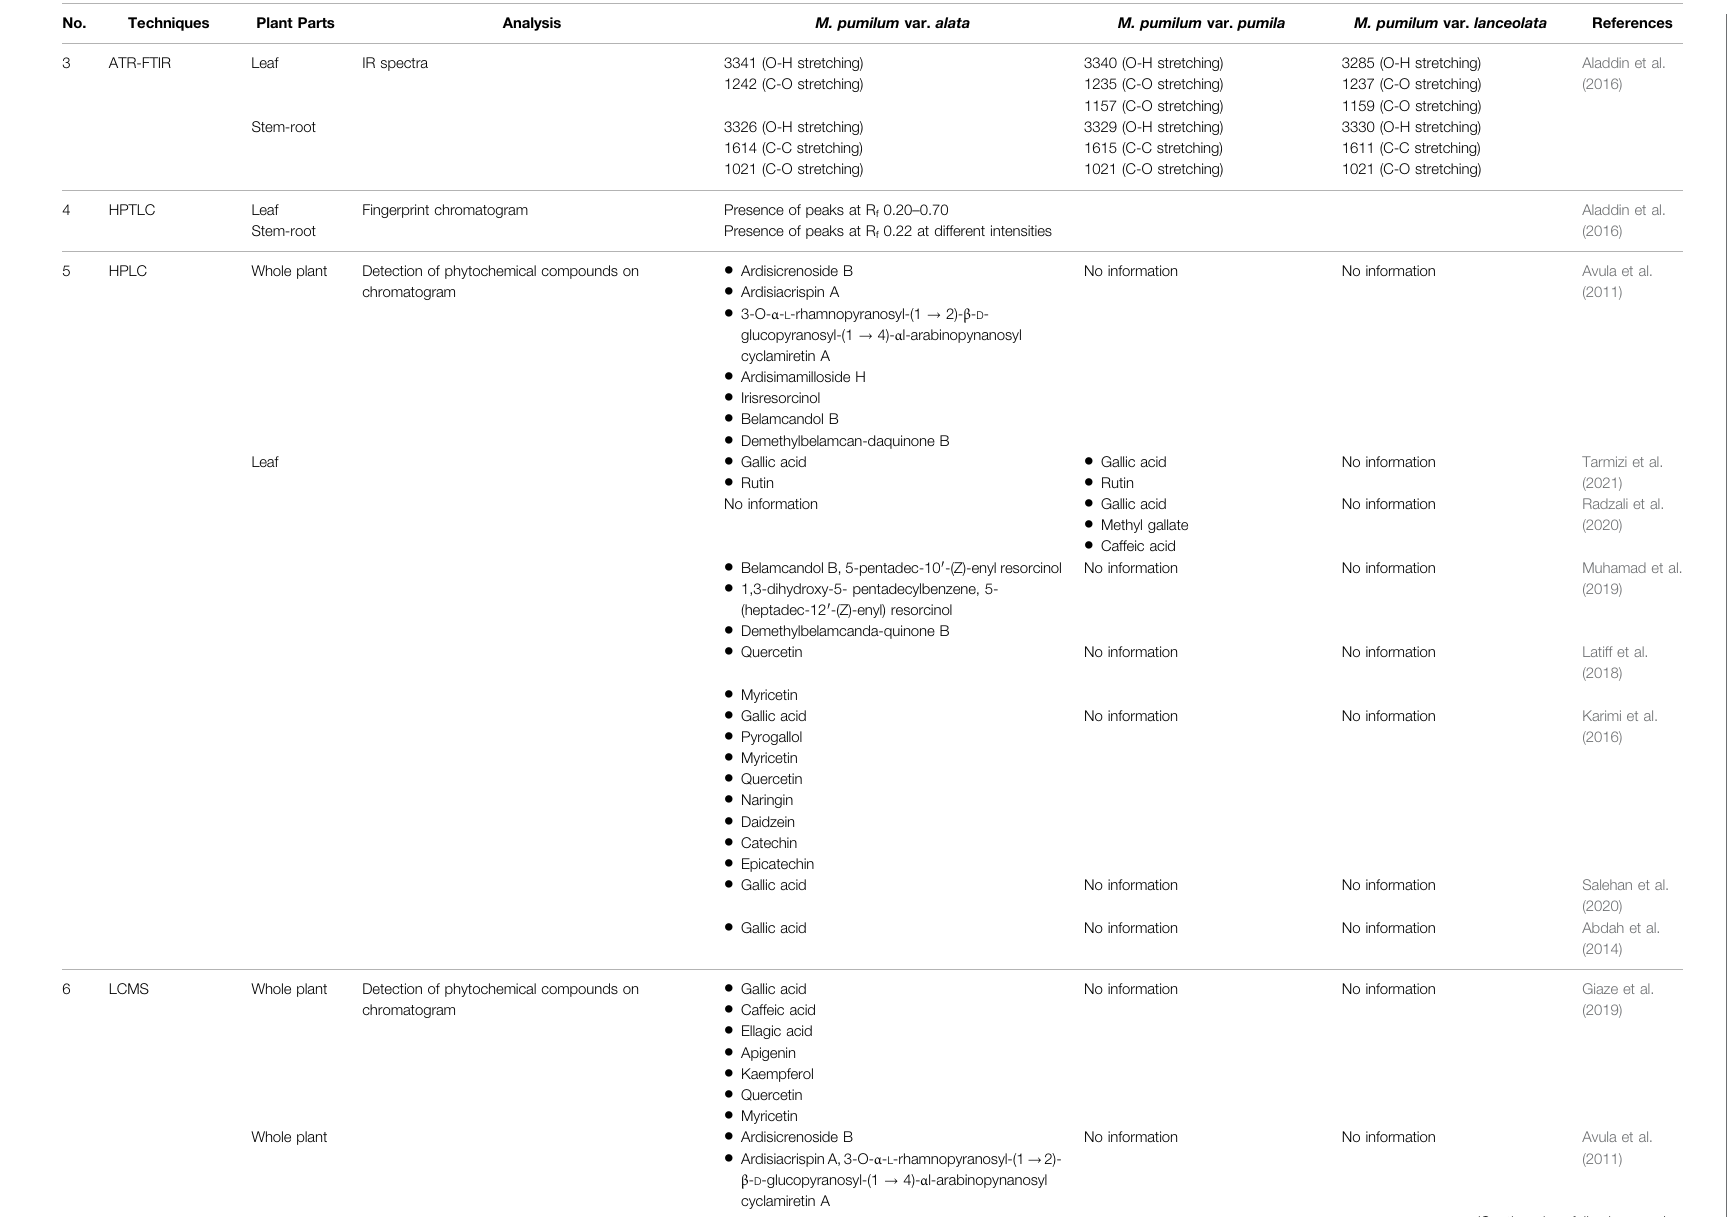
TABLE 2 | ( Continued ) Characteristic features to distinguish Marantodes pumilum varieties based on different analytical